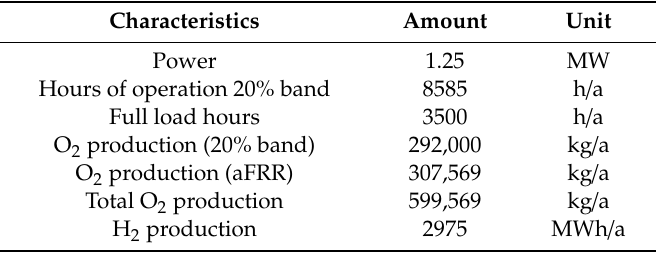
Table 2. Characteristics and performance data of the 1.25 MW electrolyzer.